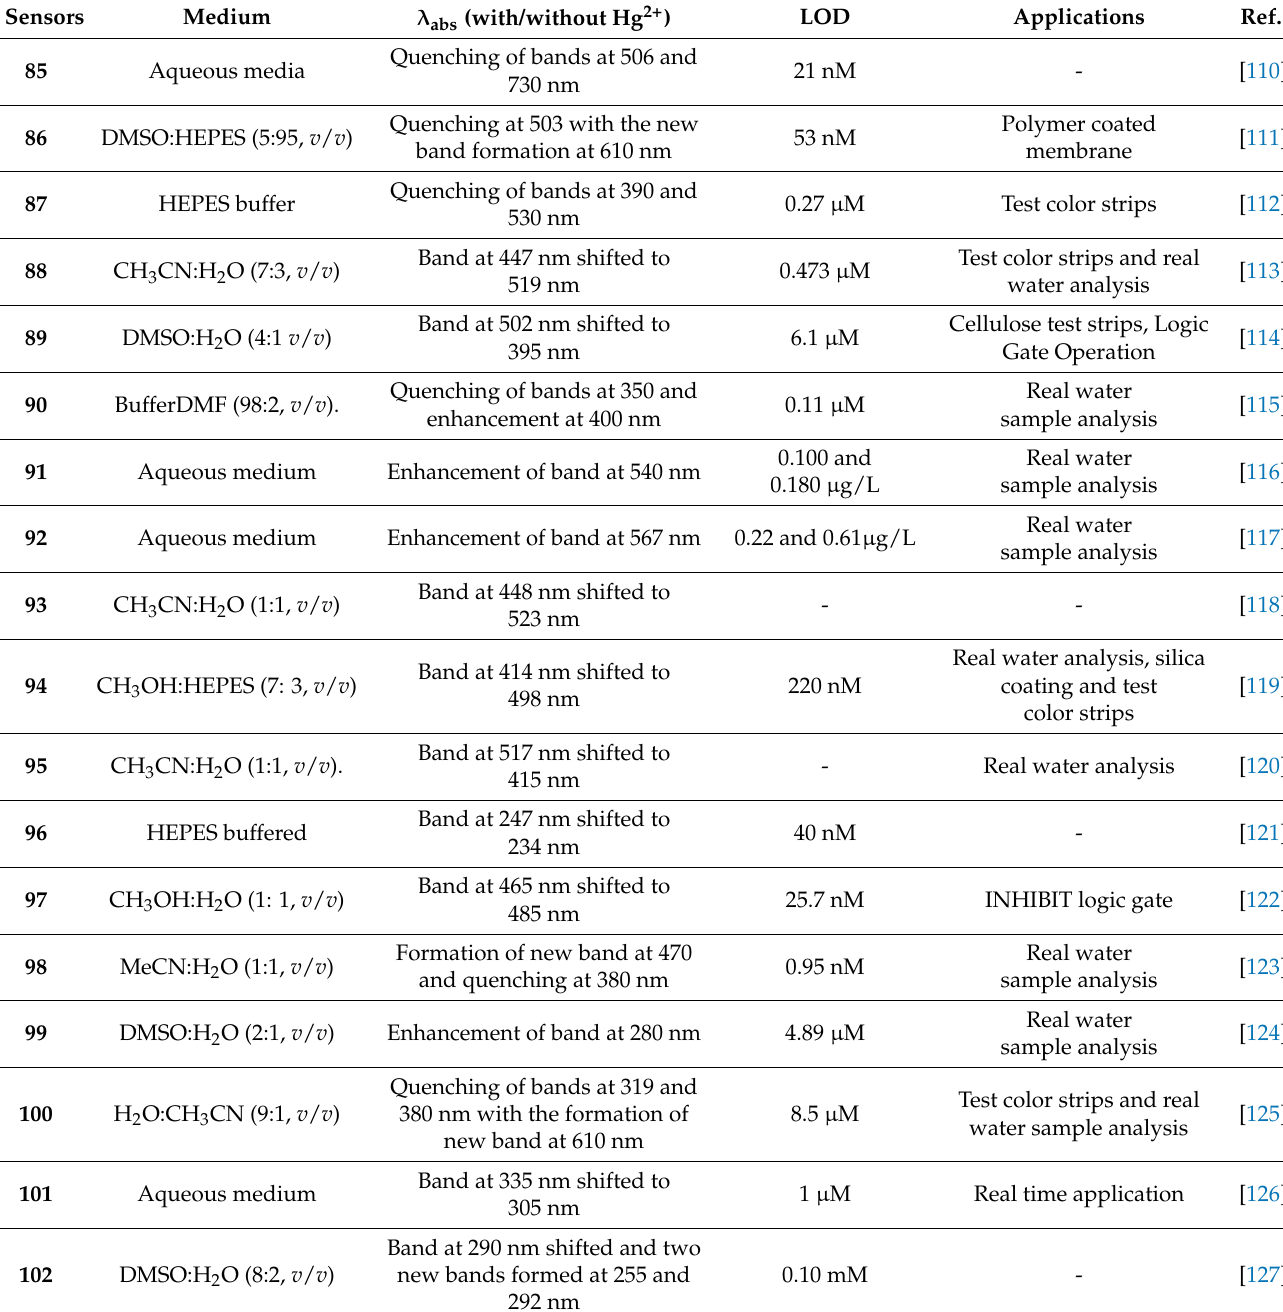
Table 3. Analytical parameters of the colorimetric sensors 85 to 102